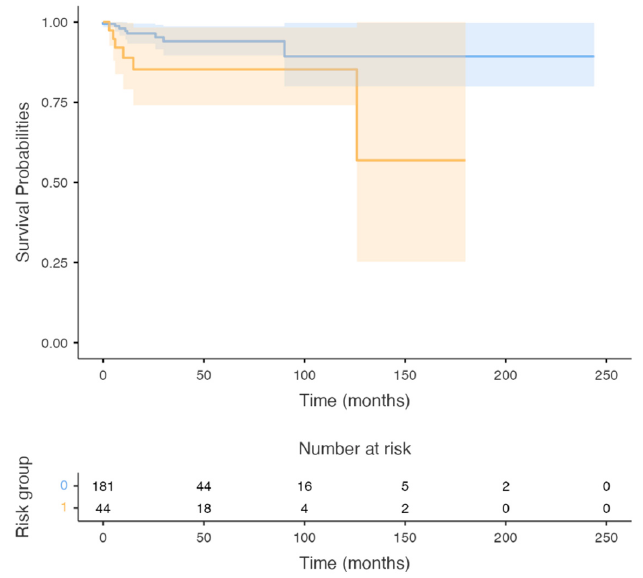
Figure 3. Survival Curve: The survival of patients staged as stage III by the seventh edition of the AJCC staging manual and who were upstaged to stage IVa according to the N category of the eighth edition, compared to patients that remained at stage III. ( p -value < 0.005). edition, compared to patients that remained at stage III. ( p -value <